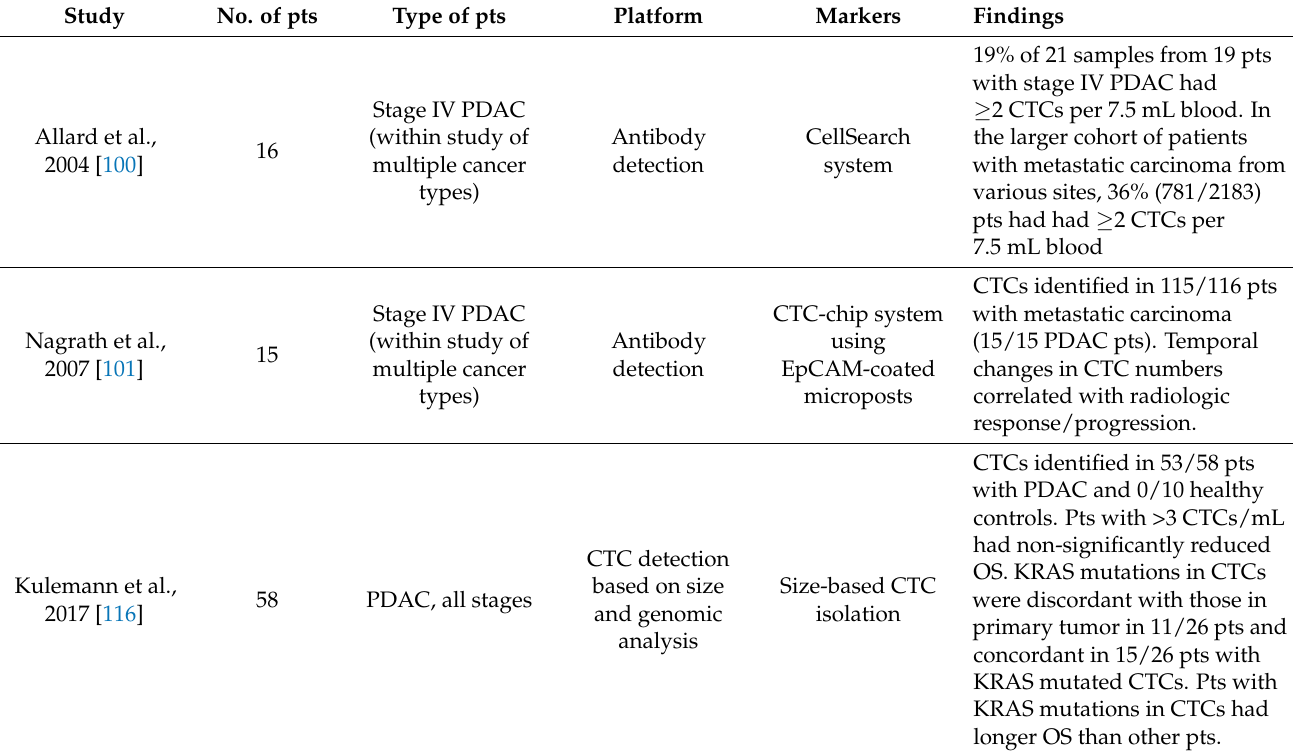
Table 3. Studies of circulating-tumor cells in pancreatic ductal